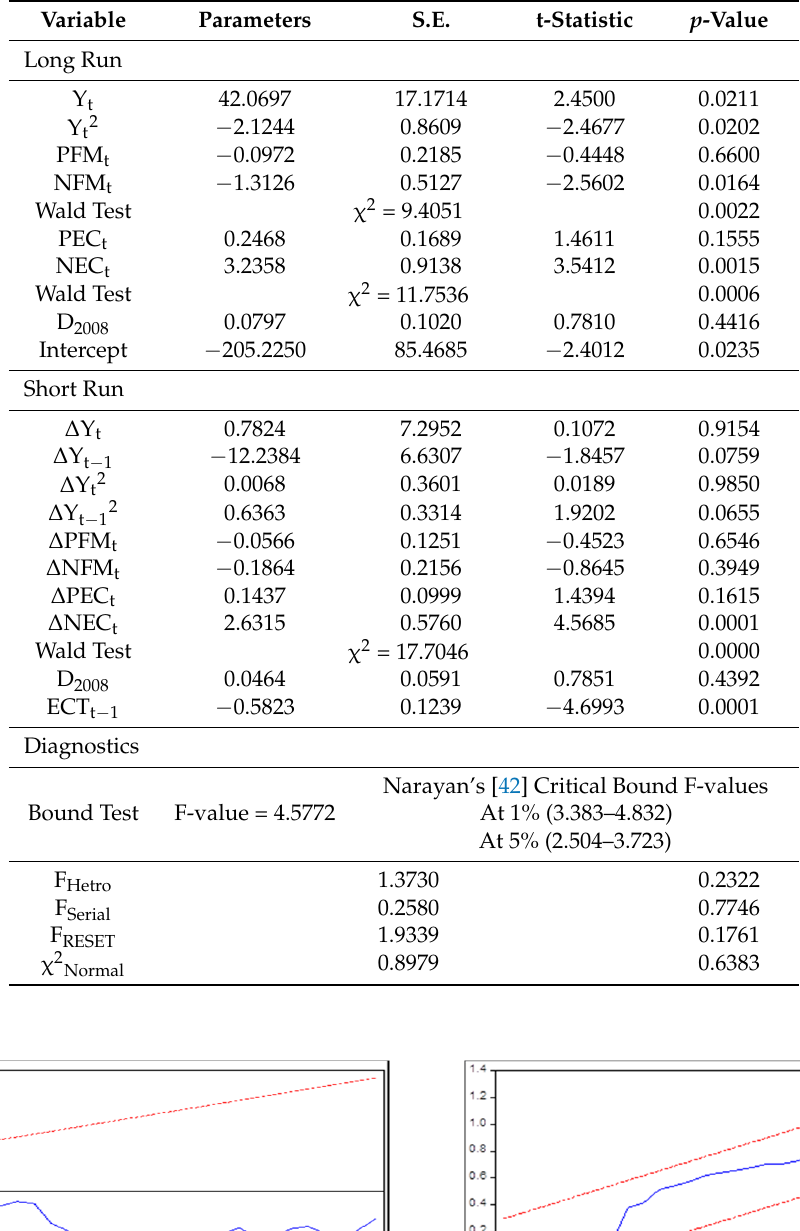
Table 3. CO 2 emissions per capita model results.